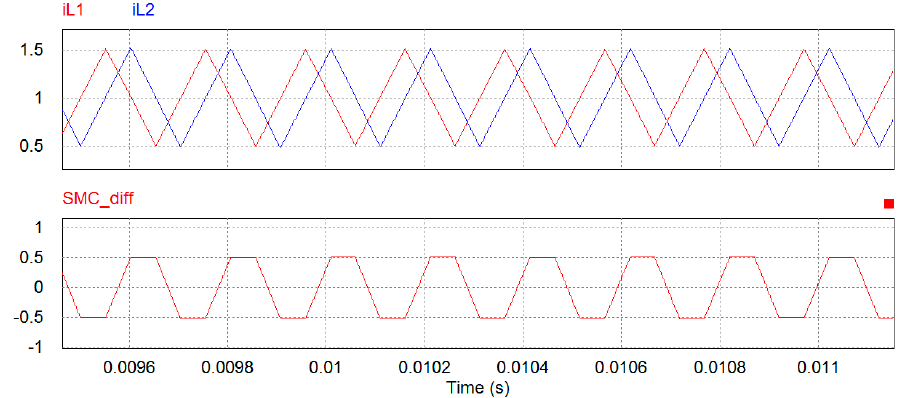
Figure 11. 1/4 T s of the phase error of the inductor currents (upper) and s 2 * sliding surface (lower).